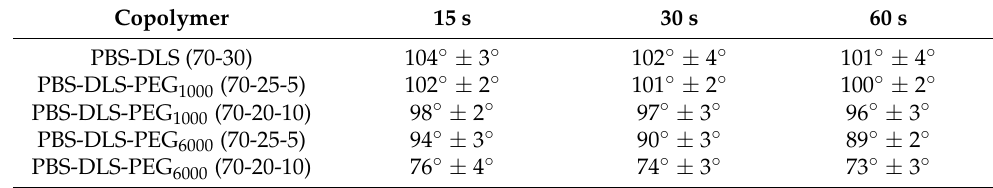
Table 4. Summary of the water contact angle of the copolymer surface measured at different times.